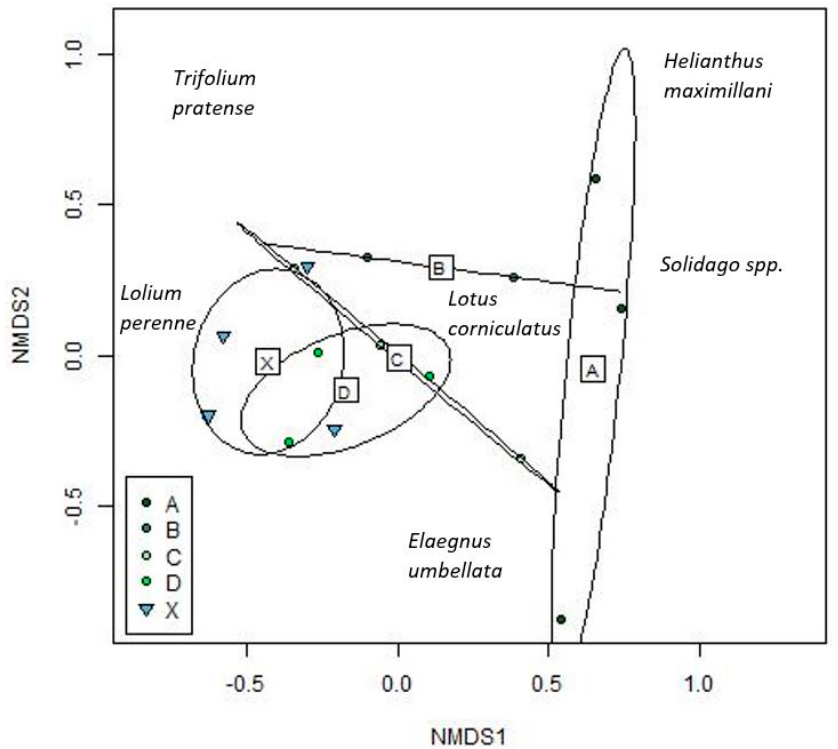
Figure 1. Grassland vegetation communities in 2018. Dominant plant species were chosen to represent each axis. Ellipses represent grassland groupings: ( A ): Prairie aged 14–19 years ( B ): Prairie aged 8–10 years ( C ): Prairie aged 4 years ( D ): Prairie aged 2 years ( X ): Baseline (cool season). Circles represent prairie grasslands, and triangles represent baseline cool season grasslands.